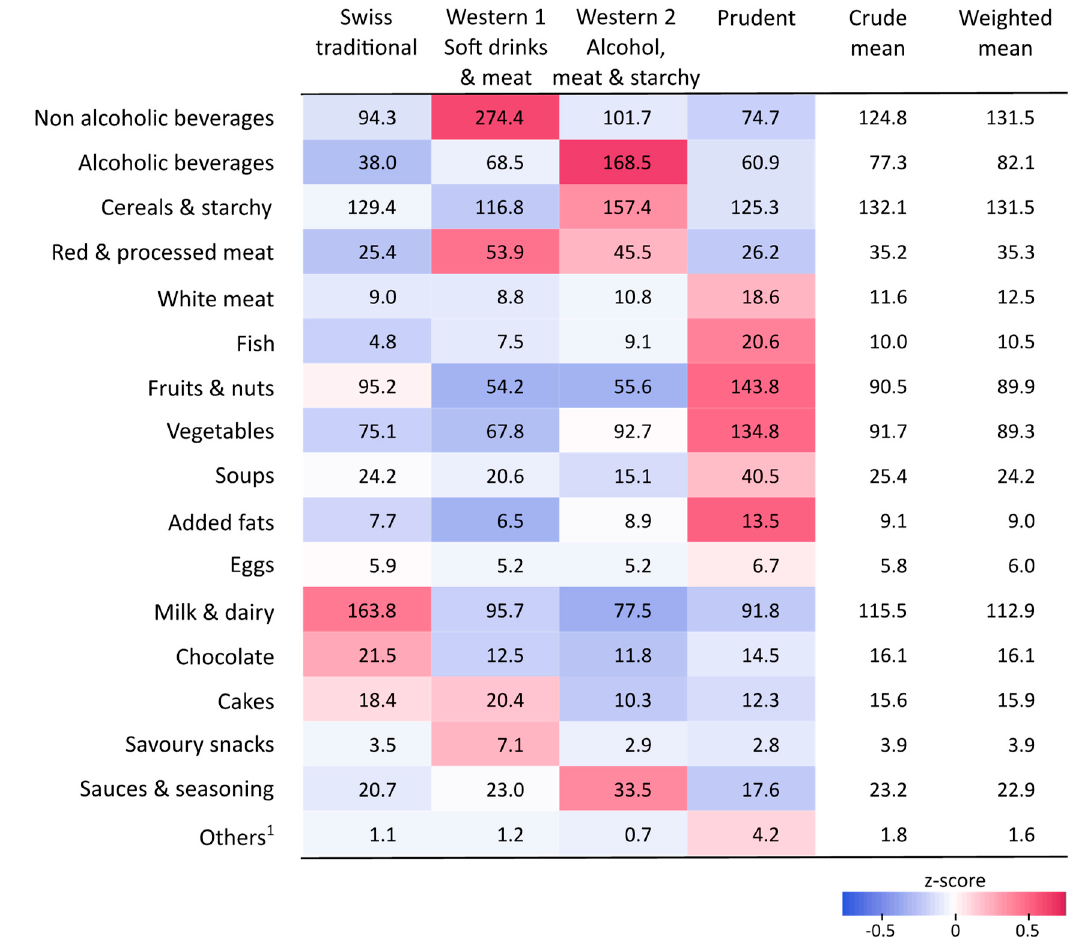
Figure 2. Amounts of food consumed in the four dietary patterns and the overall population and energy-standardised consumptions of the 17 food categories (in g/1000 kcal) in the four dietary patterns and the overall study population. The weighted mean provides estimates of the mean consumption corrected for sex, age, marital status, major area, household size, nationality and the uneven distribution of 24-h dietary recalls over seasons and weekdays. Colors indicate the mean of the energy- and z-standardised consumption of one food category within one dietary pattern. 1 Others include meat substitutes, milk substitutes and meal replacements (all categories are described in Table S1, Supplementary Materials).